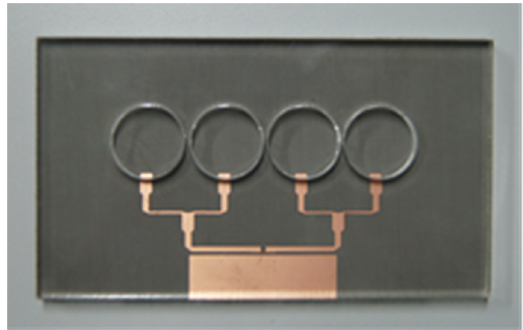
Figure 6. Perspex mould positioned above.